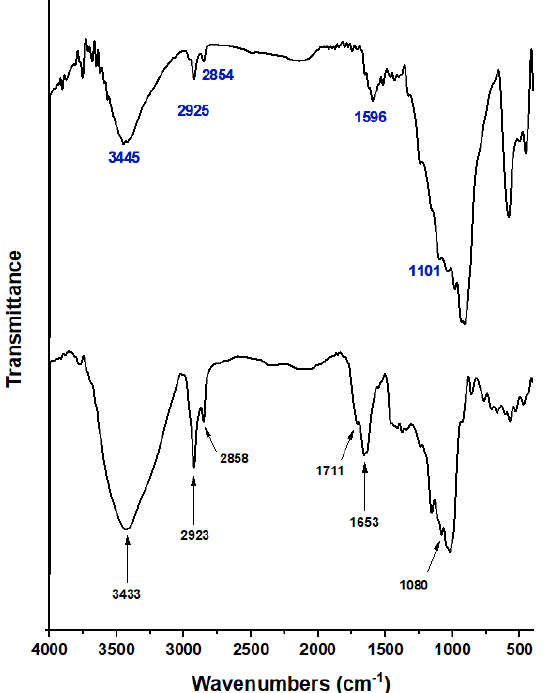
Figure 2. TEM image of the prepared activated carbon.